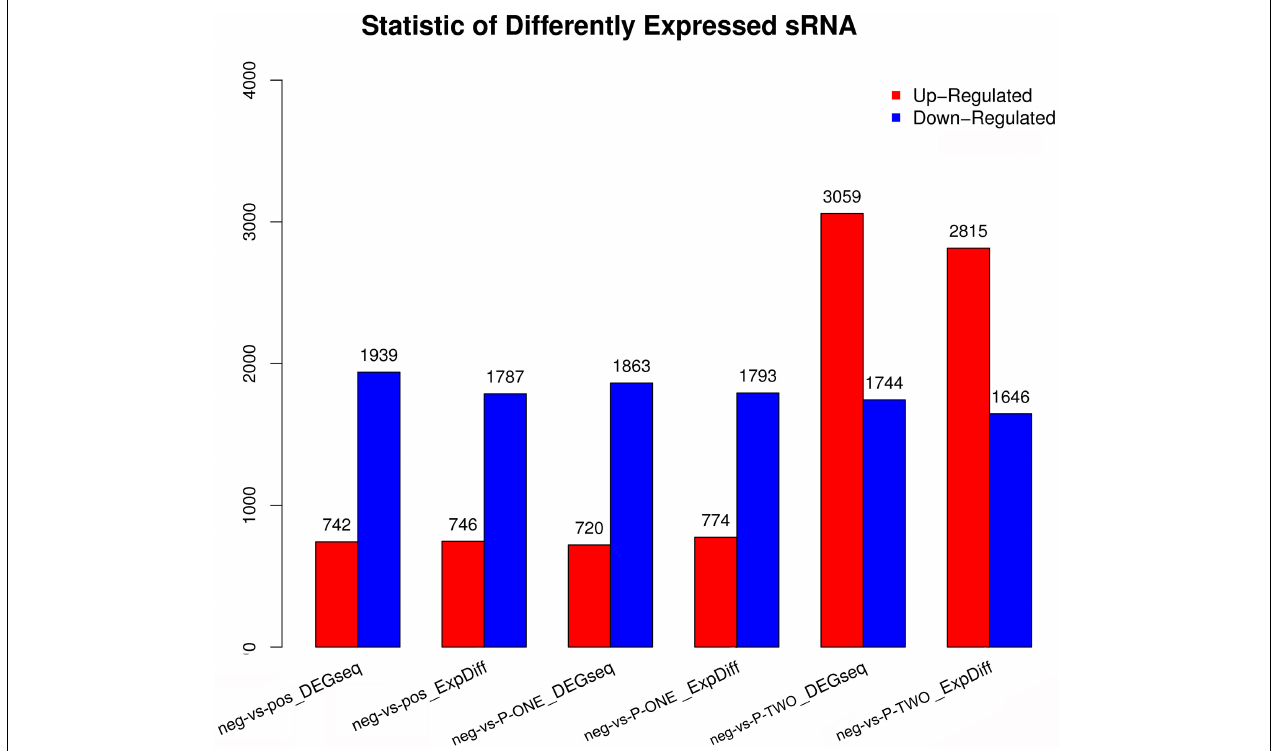
FIGURE 6 | Statistic of differential expressed miRNAs. Using DEGseq nad ExpDiff, we identified the differentially expressed miRNAs from four gourps: 1) negative control group (neg); 2) positive control group (pos); 3) P-ONE group; 4) P-TWO group. X -axis represents pairwise and Y -axis means number of screened DESs. Blue bar denotes down-regulated and orange bar for the upregulated. According to the figure, P-ONE and traditional HR4-targeted method may have similar regulatory mechanisms via microRNAs but P-TWO may have its specific pharmacological effects and mechanisms via microRNA regulation.